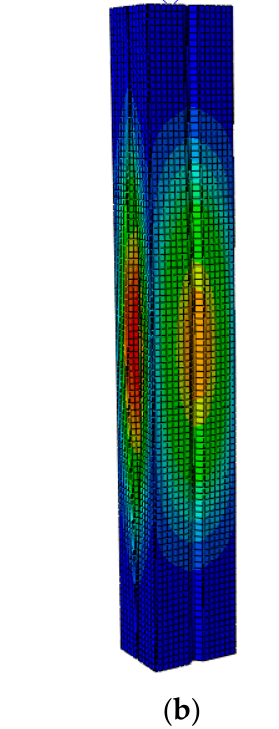
Figure 14. Contours of initial imperfection for face-to-face intermediate stiffened channel sections (FISCS). ( a ) Local buckling (FISCS-1). ( b ) Distortional buckling (FISCS-3).